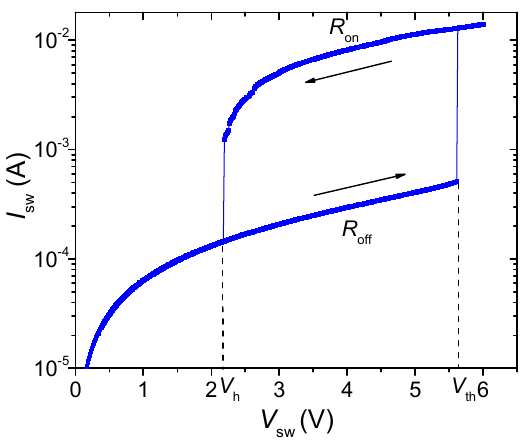
Figure 1. Experimental I–V characteristic of a planar VO 2 switch.